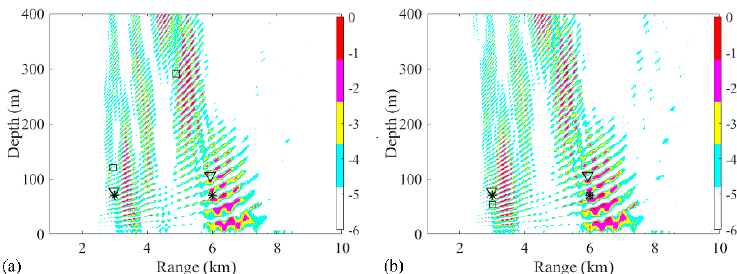
Figure 5. ( a , b ) Ambiguity surfaces generated by different realizations with the elements of the VLA 8 m apart (from 1735 to 1859 m), compared to the results shown in Figure 3. True source positions and the positions estimated by the RAMP and RAMPMF methods are represented as black asterisks, squares, and inverted triangles, respectively.